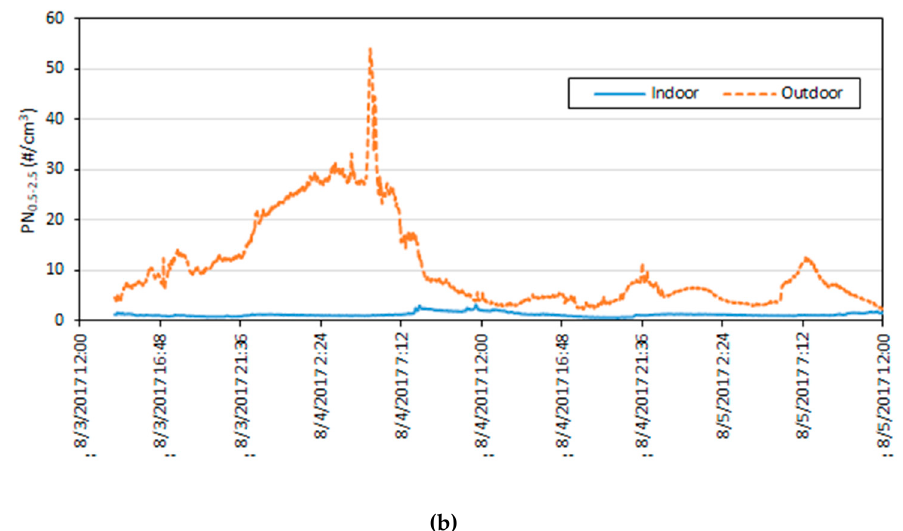
Figure 5. Indoor and outdoor time series PN 0.5–2.5 data from two of the homes tested (Figure ( a ): Home T442, Figure ( b ): Home T450).